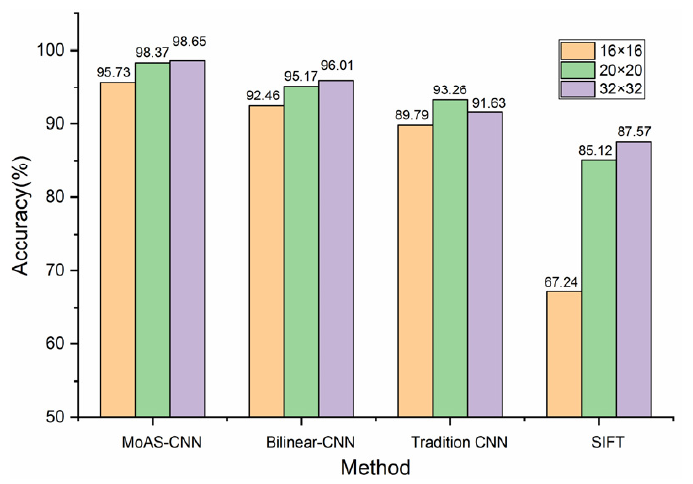
Figure 11. Performance comparison with other first-order, second-order and traditional local feature methods. For the samples that the model failed to identify, the true labels and predicted prob- abilities are shown in Figure 12, marked in orange. These haptic images are collected in a random pressure range of 0.5–3 kPa, angle and position. The inference value of some letter categories with similar shapes are very close, indicating that the differences between features are not obvious. As a comparison, 10 volunteers (7 males and 3 females, age [20,30] are invited to identify the misclassified samples and the results are marked in green. It can be observed that some samples were not recognized by the neural network or humans, as shown in Figure 12a–f, and others were recognized by humans, but not by neural networks, as in Figure 12g–i. No volunteer can completely reclassify all failed samples. The misclassi- fication can be mainly attributed to the following: firstly, the restricted sensor density leads to fine edges not being captured; secondly, the elastic coupling of the flexible sensors causes the unpressed pixels around the pressed pixels to be deformed, producing pseudo-outputs. Thirdly, features are not sufficiently mined through the MoAS-CNN and the features of similarly shape categories are not learned